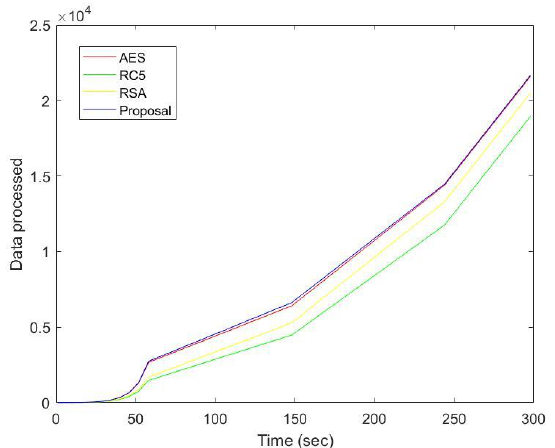
Figure 7. Performance of data processed (megabytes) comparison of the AES, RC5, RSA, and proposed model.